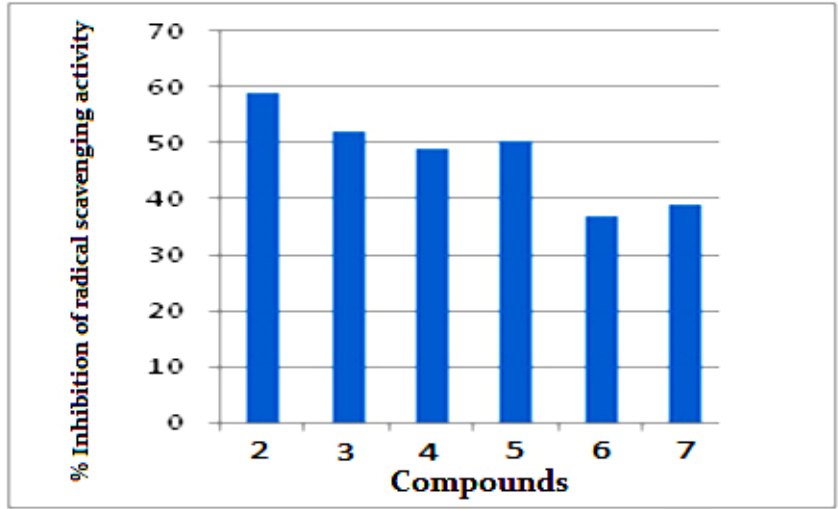
Figure 5. Radical scavenging activity of 2 – 7 using ABTS radical